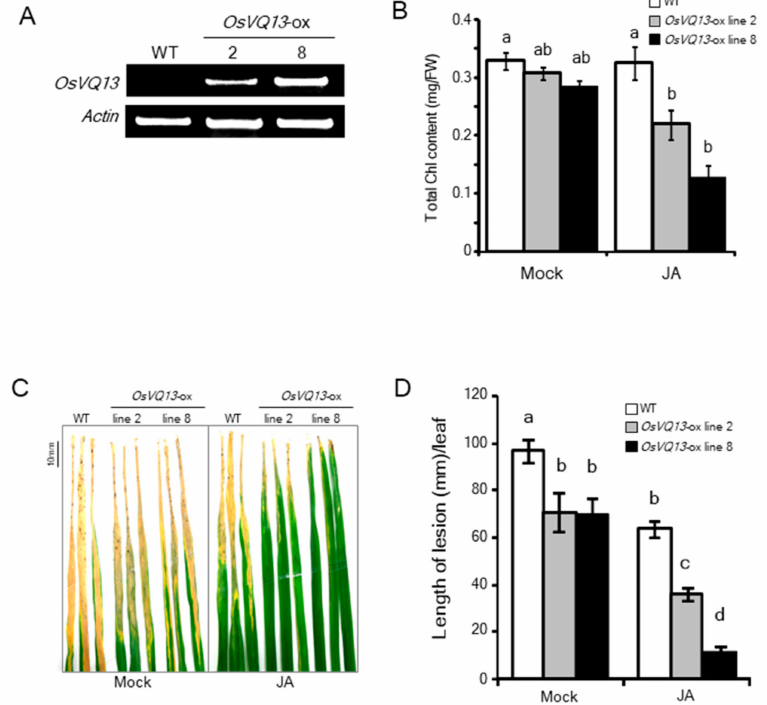
Figure 2. Phenotype of OsVQ13 -overexpressing rice plants. ( A ) RT–PCR analysis of OsVQ13 and actin expression in wild-type (WT) and OsVQ13 -overexpressing rice plants ( OsVQ13 -ox; lines 2 and 8). ( B ) Total chlorophyll content in leaf blades after treatment with 100 µ M of JA for 3 d in WT and OsVQ13 -ox rice plants. Values are means ± SE. Data were analyzed using Tukey’s HSD test ( n = 4 for each genotype). Bars with di ff erent letters are significantly di ff erent at p < 0.05. ( C ) Disease symptoms of rice bacterial blight in WT and OsVQ13 -ox with mock or 100 µ M of JA pretreatment for 24 h. The fifth leaf blades were photographed 14 d after inoculation with Xoo . ( D ) The length of lesions on the fifth leaf blades at 14 d after inoculation with Xoo with pretreatment with 100 µ M of JA for 24 h. Values are means ± SE. Data were analyzed using the Tukey–Kramer test ( n = 12 for both WT mock and JA; n = 7 for line 2 mock; n = 12 for line 2 JA; n = 10 for line 8 mock; n = 12 for line 8 JA). Bars with di ff erent letters are significantly di ff erent at p <